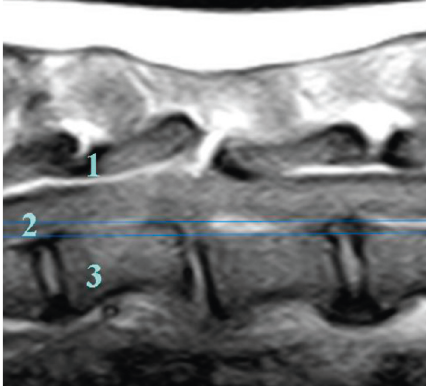
Figure 1: Sagittal T1-weighted MR image of the thoracic spine of one dog showing rupture of all three compartments, suggesting vertebral